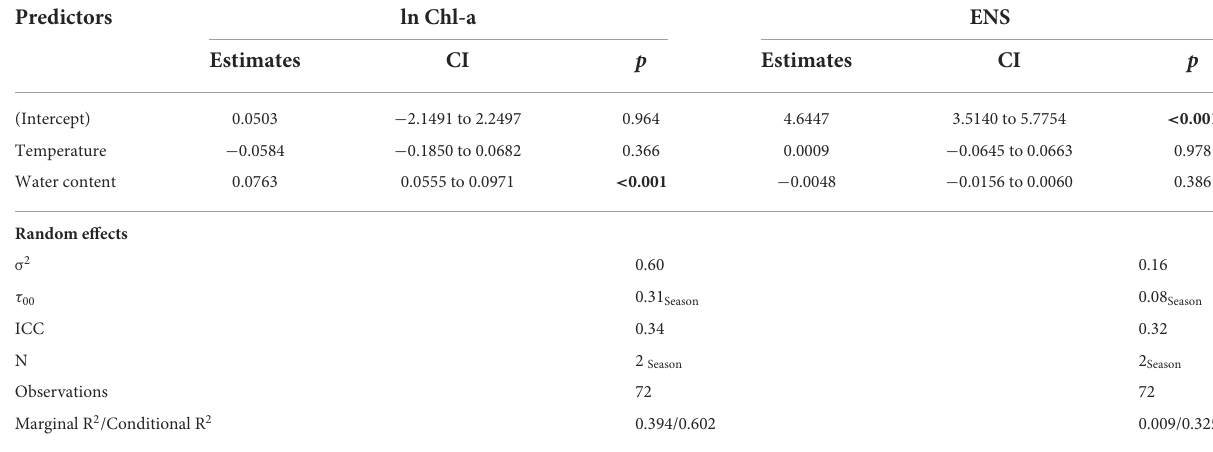
TABLE 3 Linear mixed effects model output from the analysis of the response variables chlorophyll-a and pigment diversity (ENS) against the predictor variables: temperature and sediment water content on experimental islands.